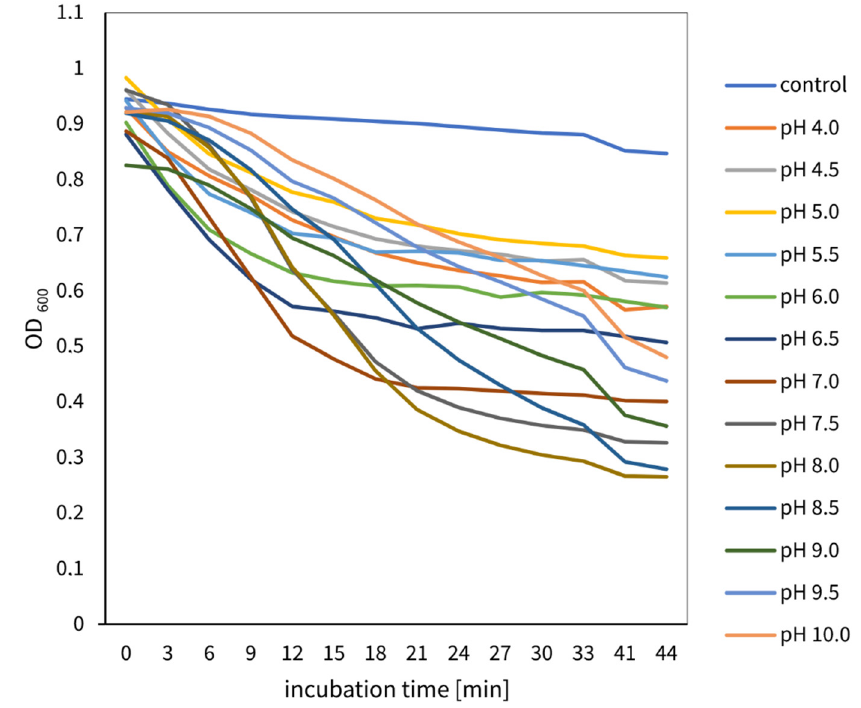
Figure 5. Effect of reaction pH on the muralytic activity of recombinant TP84_28 endolysin. The TRA assay, conducted as in Figure 4, tested reaction buffers with various pH values ranging from 4 to 10.